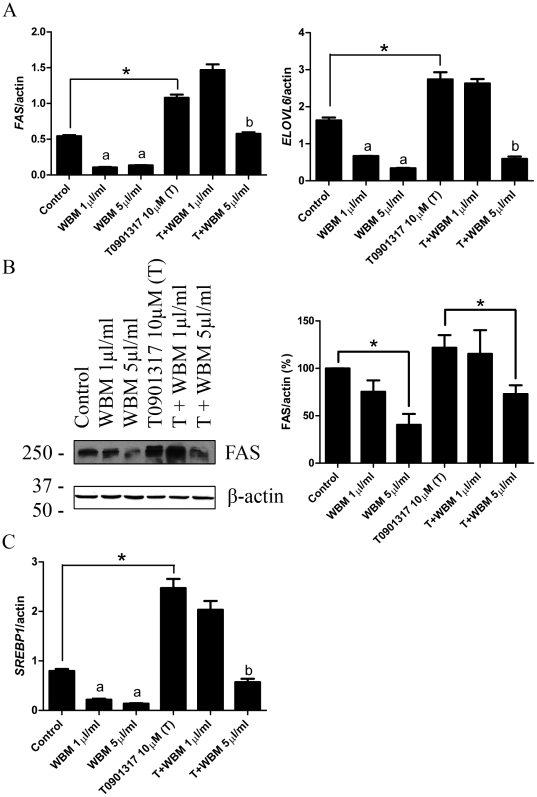
Changes in the mRNA and protein levels of genes related to fatty acid synthesis pathway in HepG2 cells treated with WBM extract.Cells were incubated with vehicle control (Ethanol), T0901317 (10 µM) and/or WBM extract (1 and 5 µl/ml) for 24 hours for RNA and 48 hours for protein, respectively. (A) FAS and ELOVL6 mRNA levels. Gene expression was normalized with the β-actin housekeeping gene. (B) FAS protein expressions were determined via western blotting. Bar graphs indicate quantification of three separate blots using Quantity One software. Values are expressed as mean and standard error. (C) SREBP1 mRNA levels. We analyzed the data for each dose separately by ANOVA, followed by Tukey's multiple comparison test. Statistical significance was defined as * P<0.05 compared indicated treatment, a; P<0.05 compared to control, b; P<0.05 compared to T0901317 treatment.